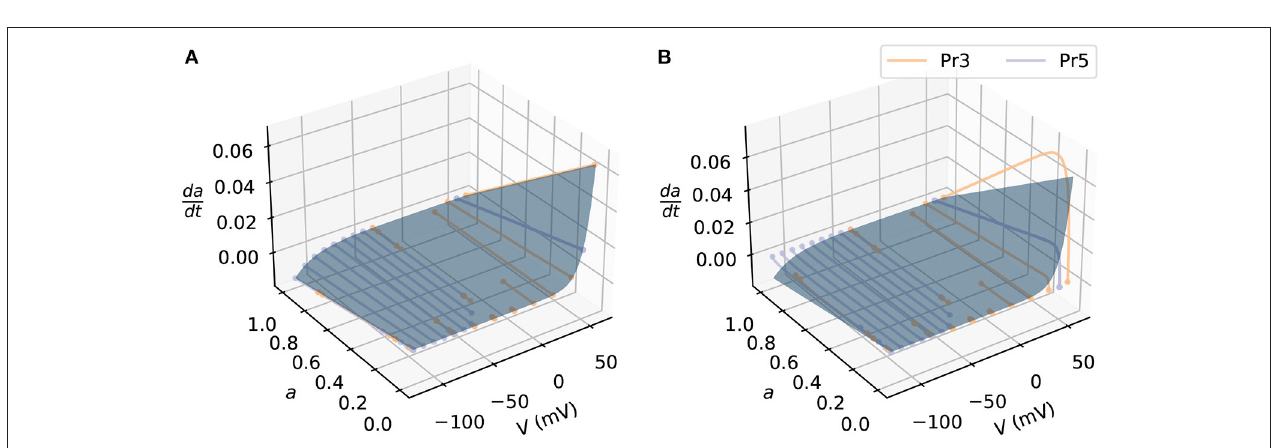
model for the real cell dataset and the results are shown in Supplementary Table 1 . All neural network models were trained using Adam’s algorithm (Kingma and Ba, 2017) via the open source PyTorch library (Paszke et al.,